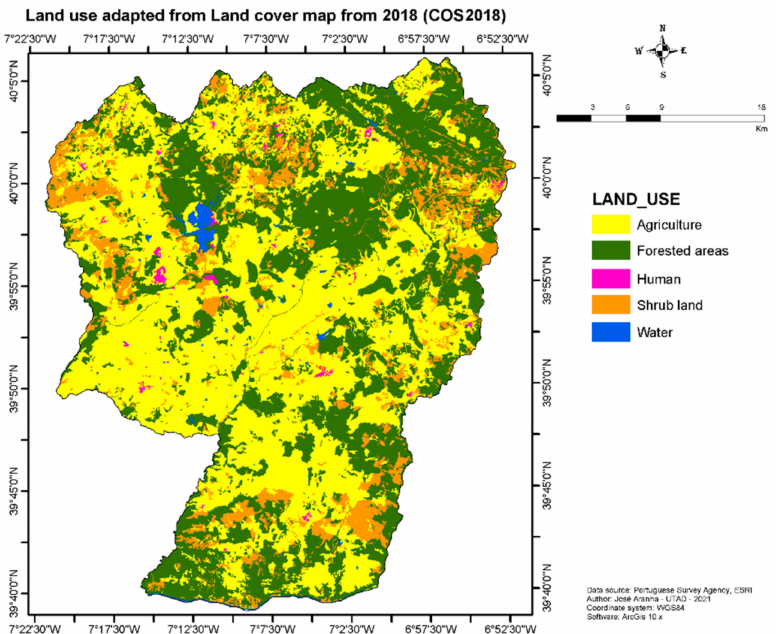
Figure 2. Land-use characteristics of Idanha-a-Nova County in Portugal, adapted from